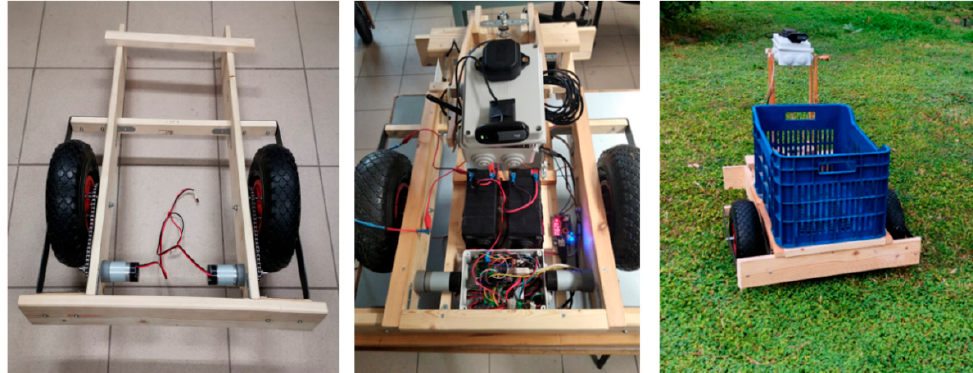
Figure 3. Indicative stages from the manufacturing process of the fruit transportation robot, from a bare wooden skeleton to a functioning whole.